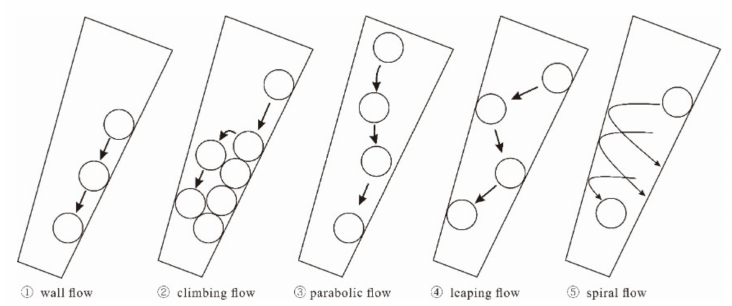
Figure 9. The flow characteristics of single